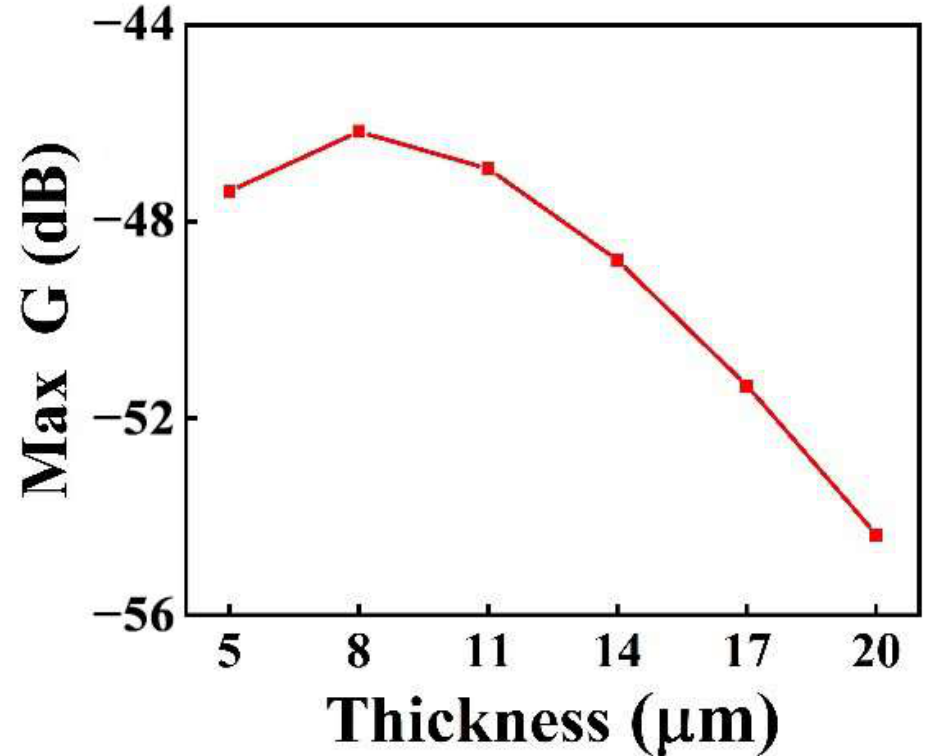
Figure 7. The loop gain (loss) at resonant frequency of the I-shaped diaphragm pMUT varies with the thickness of the piezoelectric layer.